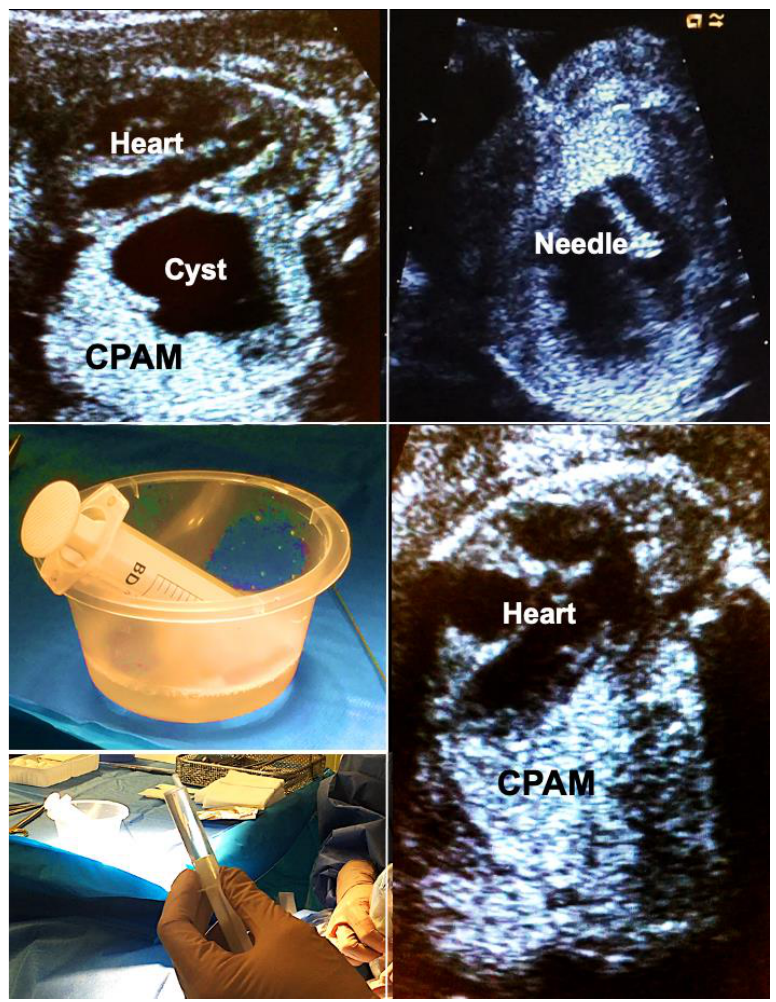
Figure 5. Alcohol ablation in hydropic fetuses with congenital pulmonary airway malformations (CPAM) permits immediate and sustained volume reduction of large, life-threatening malformations. Top left — large left-sided CPAM with contralateral displacement and compression of the fetal heart. Top right — an 18-gauge needle has been placed into a large solitary cyst of the CPAM. Middle left — 40 mL of fluid were aspirated from the cyst. Bottom left — then, the cyst is filled with 5 mL of pure ethanol. Bottom right — after 5 min, the ethanol is aspirated. Immediate improvement in cardiac filling can be observed. Hydrops usually resolves within days. In this case, the remainder of gestation remained uneventful. Survival to discharge was achieved after postnatal surgical removal of the CPAM.